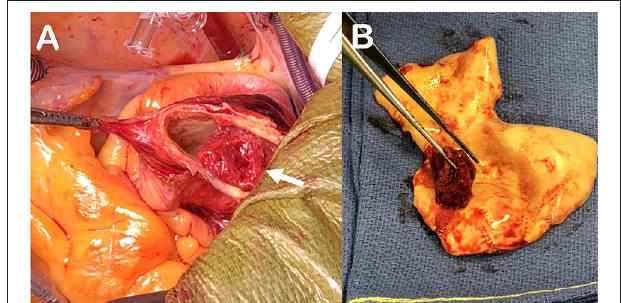
FIGURE 3 | Peroperative aspect of the thrombus visualized attached to the aortic wall at the bottom of the brachiocephalic artery [(white arrow, (A) ]. Resected aspect of the friable thrombus adherent to the aortic wall on a short base. The aortic inner wall is smooth without any plaque anfractuosity (B)